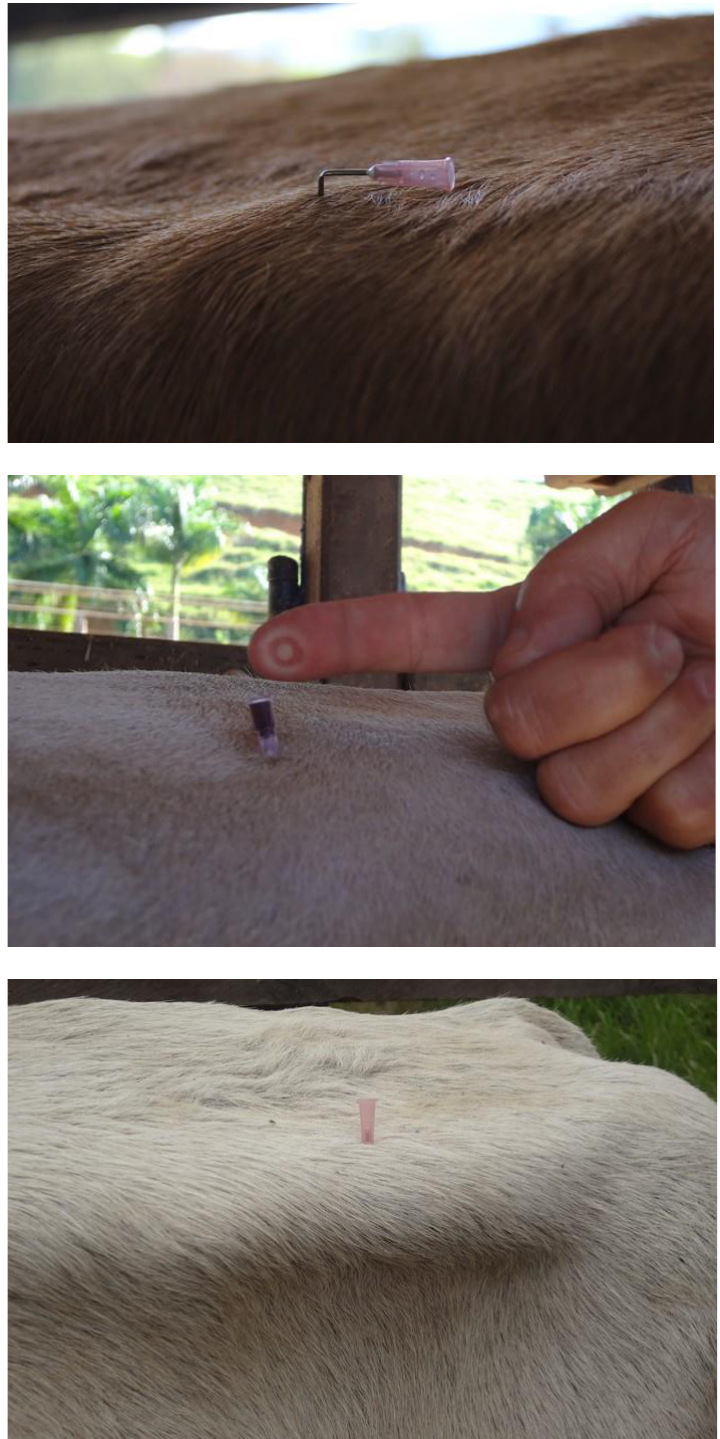
Figure 12. ( top ) Cow with no P deficiency (warped the needle); ( middle ) cow with subclinical P deficiency (note the pronounced mark on the operator’s finger) ; and ( bottom ) cow with clinical P deficiency